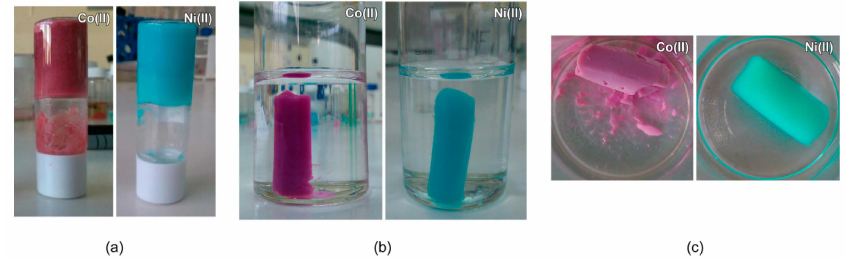
Figure 2. ( a ) As prepared gel; ( b ) gel washing; and ( c )